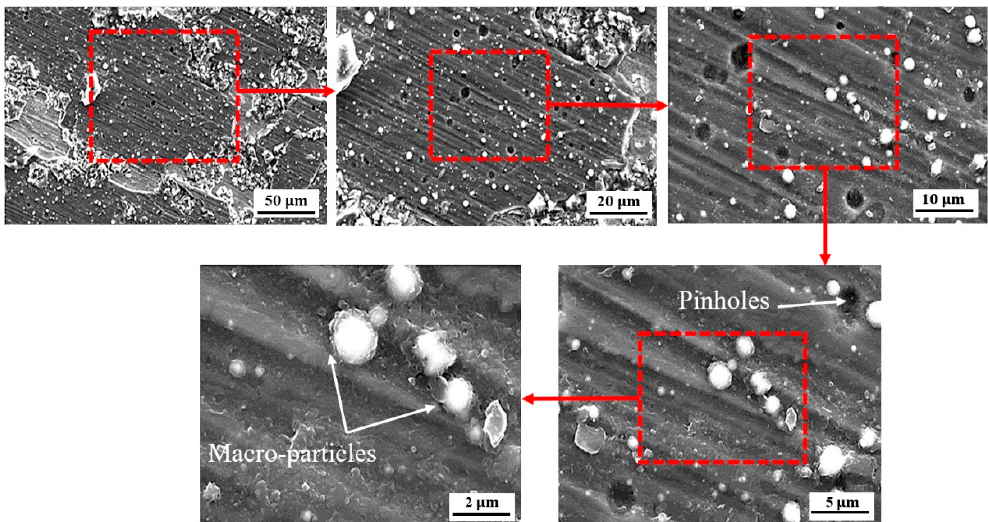
Figure 13. Surface analysis of the TiN-coated specimen following the CAE corrosion test.